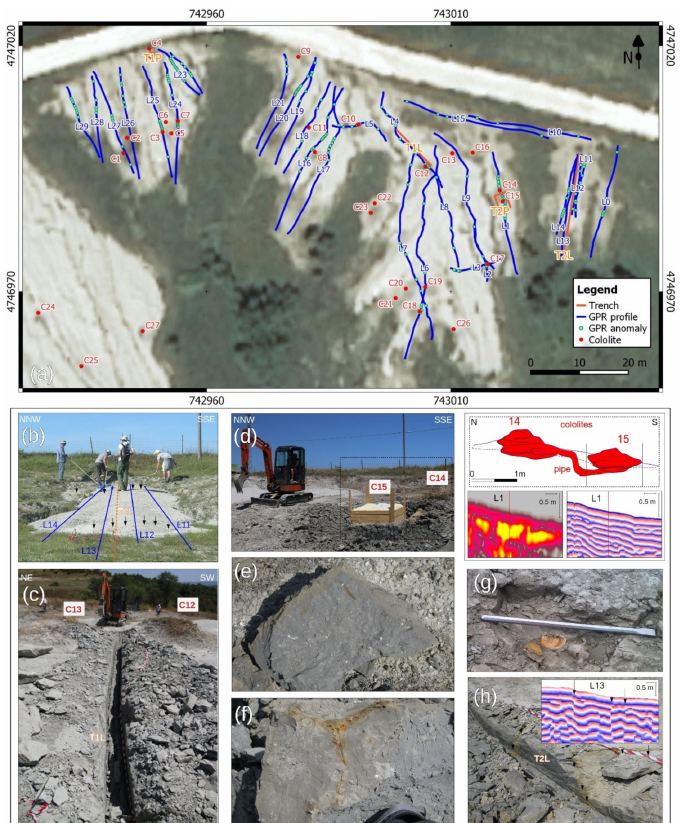
Figure 14. Excavation tests at Bargiano site; ( a ) map of the site, with the position of GPR lines (blue, purple), anomalies (green dots), excavations (orange lines), and larger cololites (red stars); ( b ) position of trench T2L in the area of GPR lines L11 to L14. Black arrows indicate emergence of vertical joints; ( c ) trench parallel to line L4; ( d ) complex morphology across structures C14-C15. Tubular buried connection between structures C14 and C15 (highlighted by a black dashed box), correlation with GPR anomalies and reconstructed buried geometry (right-side insets, excerpt of GPR attributes for L1); ( e , f ) massive clay bearing shell fragments and bioturbation, from trenches T1L ( e ) and T2L ( f ); ( g ) shell lag from the baleen site (Figure 2f), comparable to accumulations found in the T1L and T2L excavations; ( h ) example of slightly vertical fracture, along trench T2L and comparison with phase attribute for GPR profile L13 (inset, black arrows indicating the sub-vertical